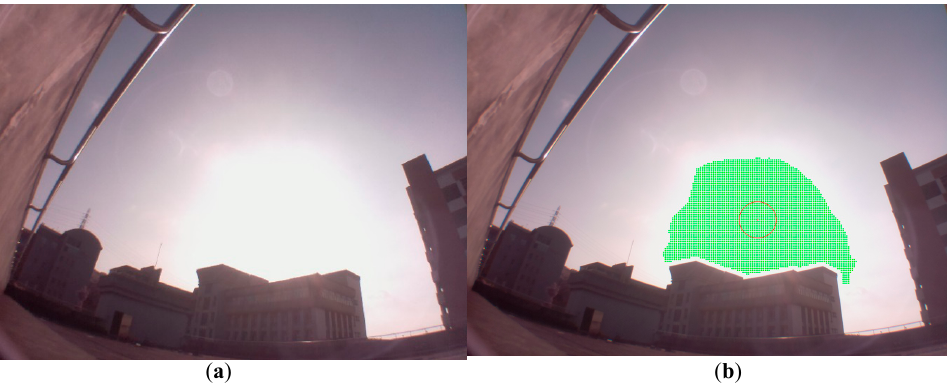
Figure 5. ( a ) The sun is sheltered by the building; ( b )The evaluated center of the sun by the brightest region method is illustrated as a red point.